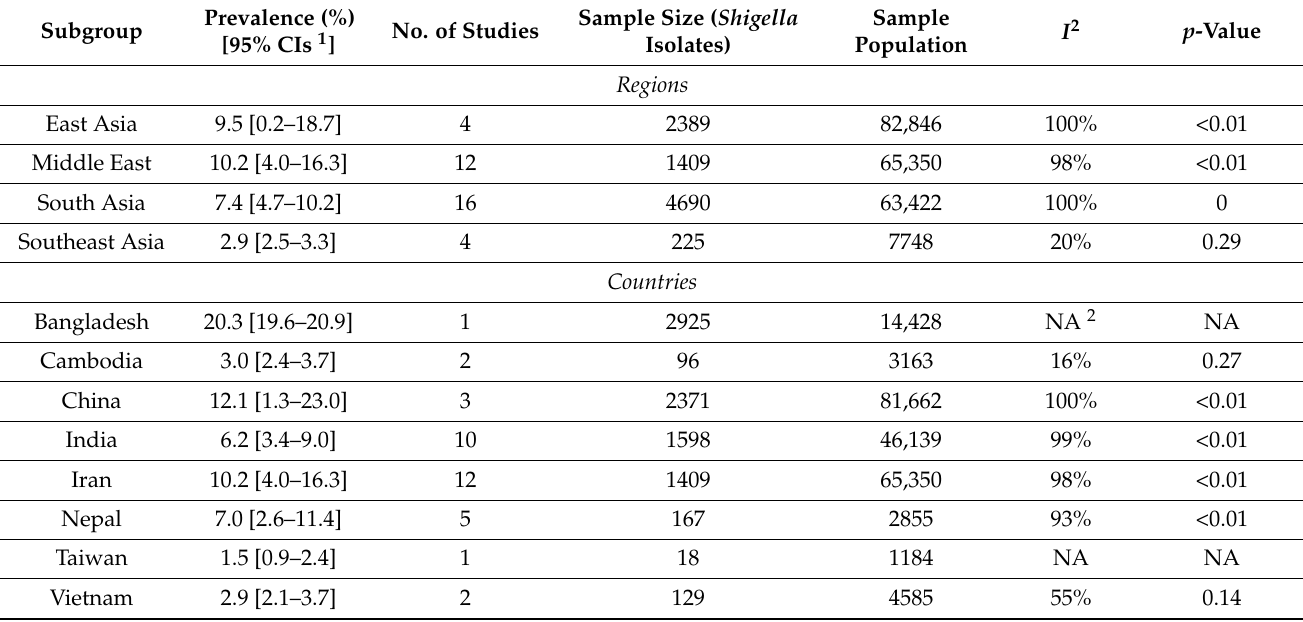
Table 2. Pooled prevalence of Shigella in different Asian